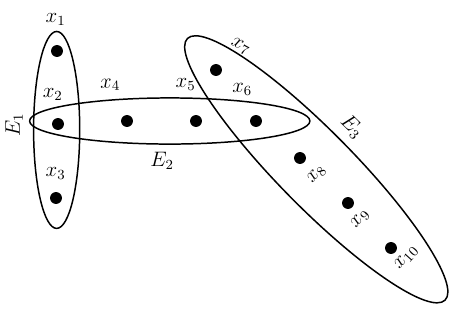
Figure 5. A partition of granules in a level.